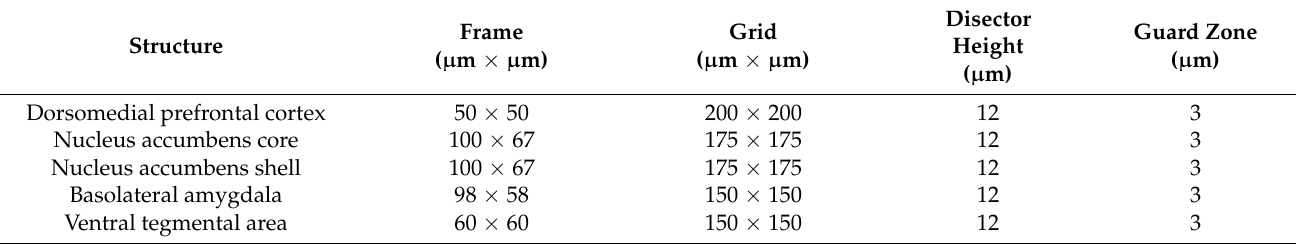
Table 2. Stereological parameters determined for each